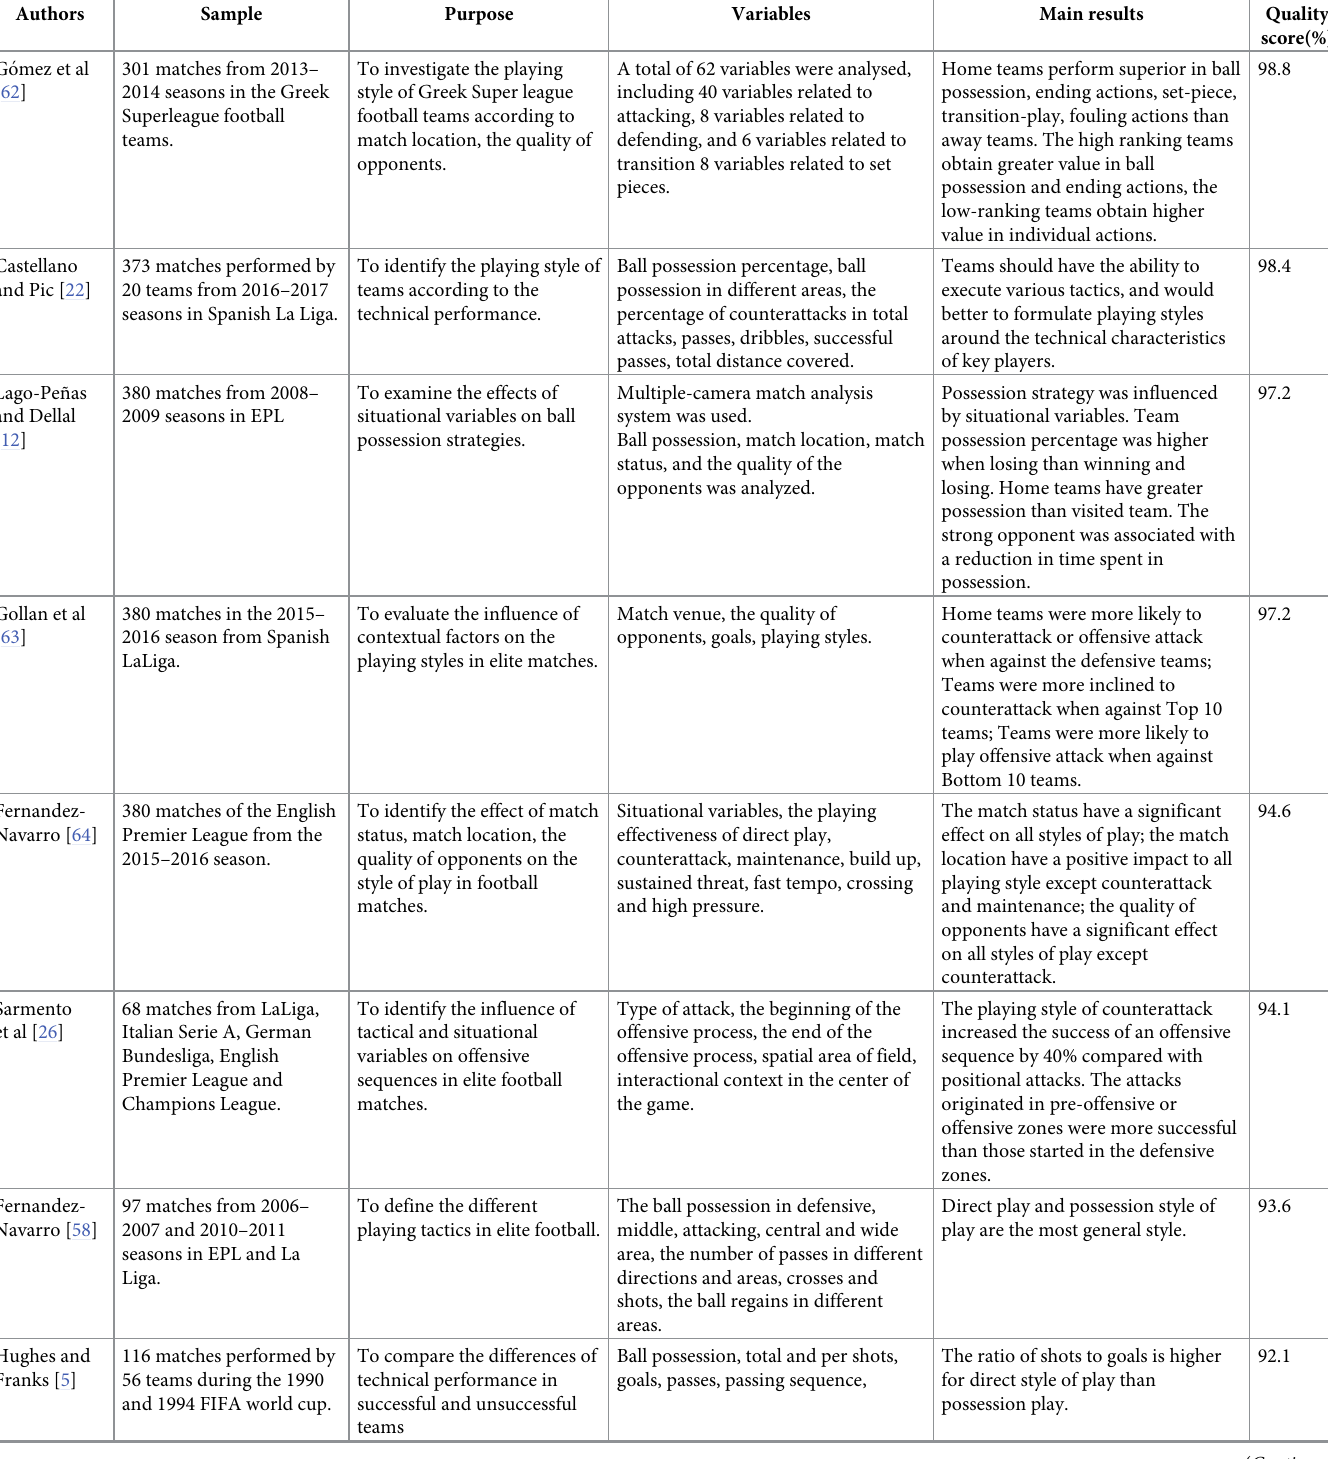
Table 2. Studies of the ball possession